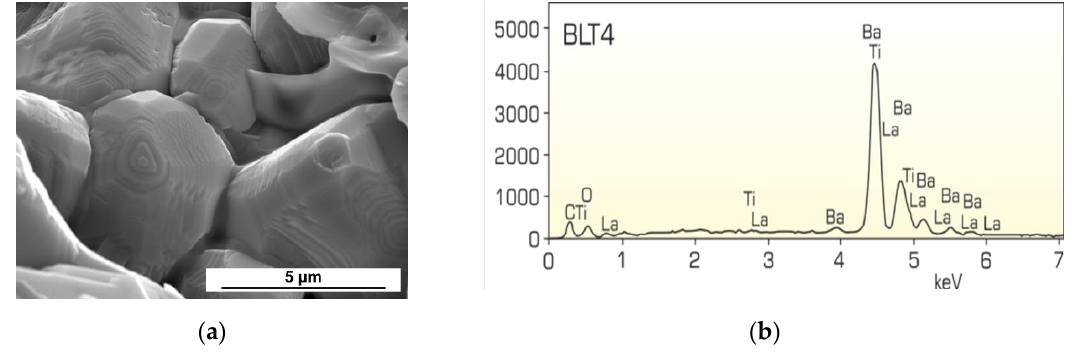
Figure 2. SEM images of fractures ( a ) and EDS emission spectrum ( b ) of BLT4 ceramics.